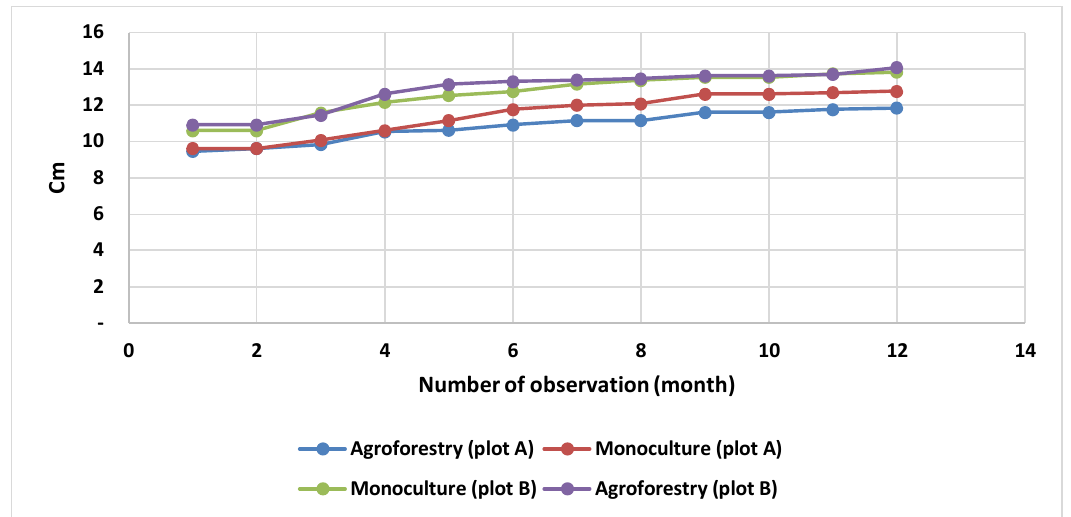
Figure 8. Circular stem growth of kemiri sunan in monoculture vs. agroforestry plots in Buntoi reseaech site in Central Kalimantan.